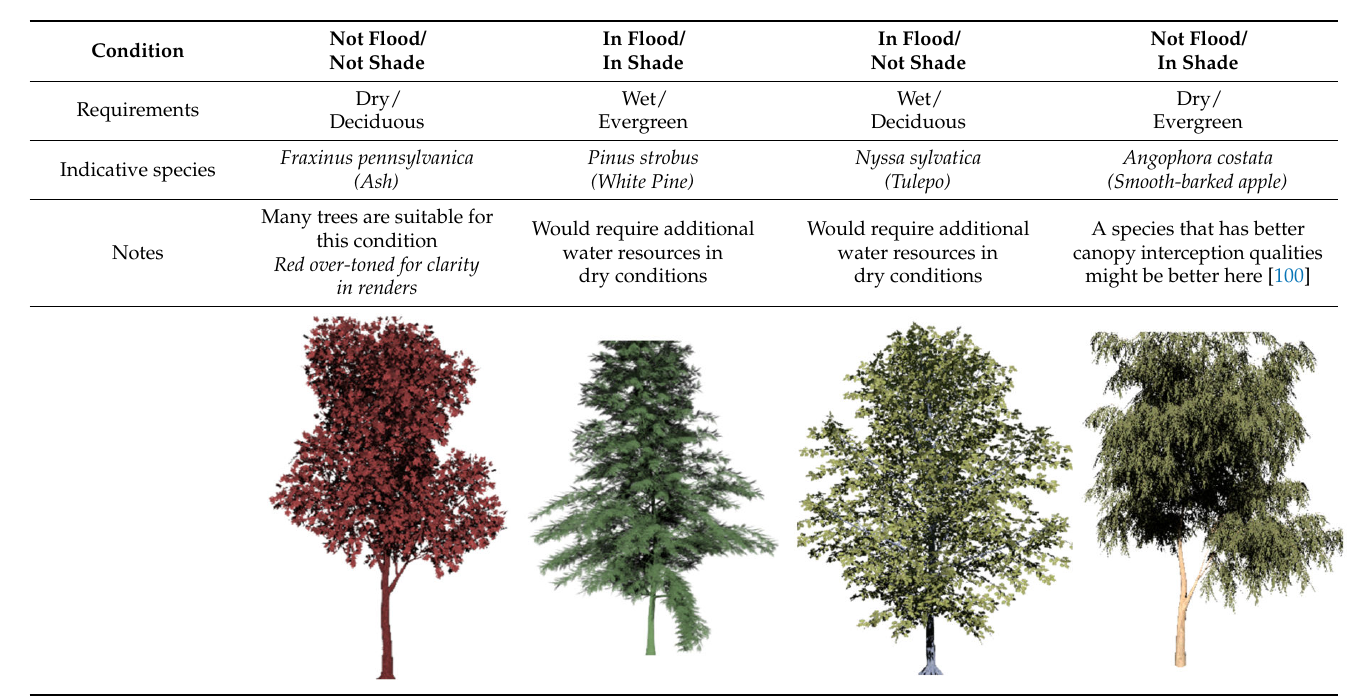
Table 3. Indicative species selection to respond to flooding conditions (in flood or not in flood) and shade conditions (in shade or not in shade). Images by authors using Autodesk™ 3ds Max™ with Xfrog™ ExLevel GrowFX™